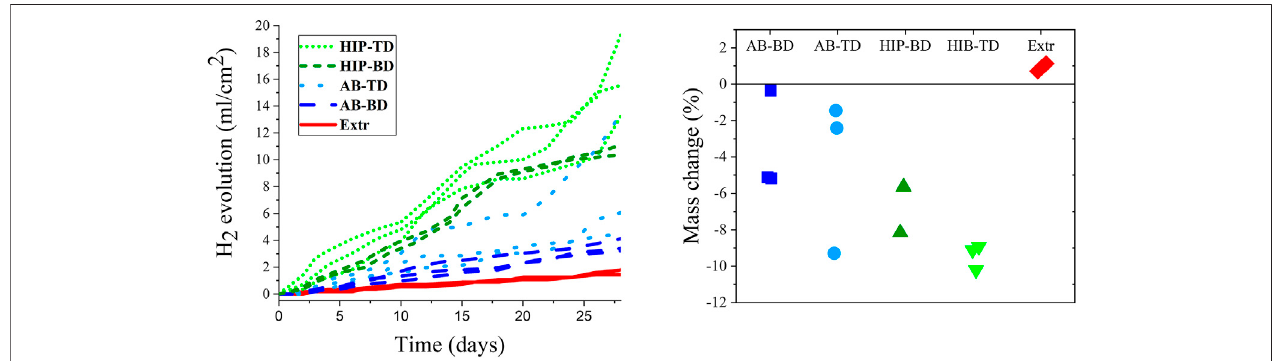
FIGURE 9 | Images of corroded samples after 28 days of immersion, with the AB surfaces in (A , D) , the HIP surfaces in (B , E) , and (C) the Extr material.